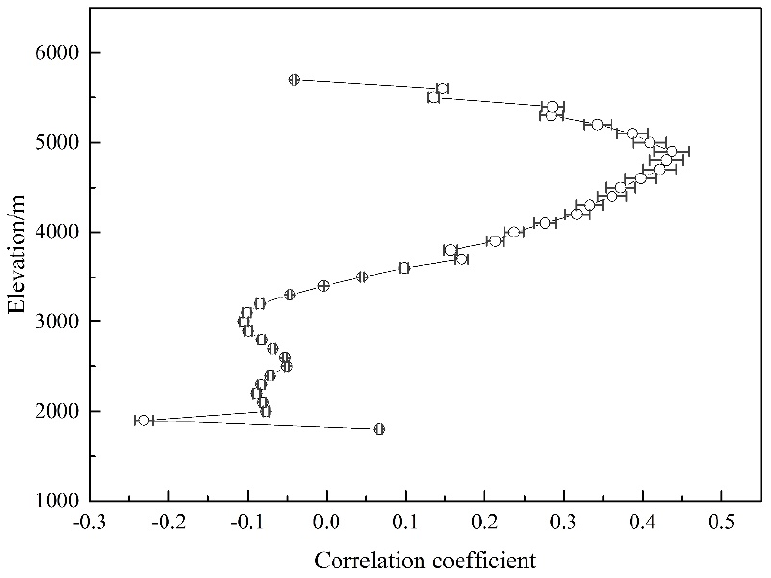
Figure 6. Correlation coefficient between snow cover extent and runoff at different elevations.